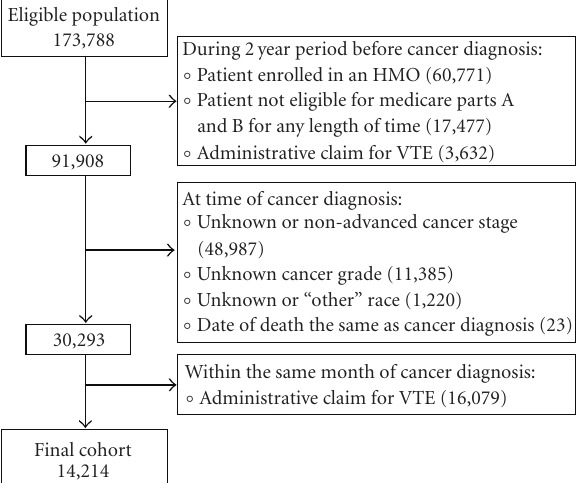
Figure 1: Construction of the cohort . The eligible population included patients listed in the SEER-Medicare Database who were diagnosed (between 1995 and 1999) with incident stage III or IV breast, lung, or colon cancer, or with nonlocalized cancer of the prostate or pancreas at the age of 67 years or